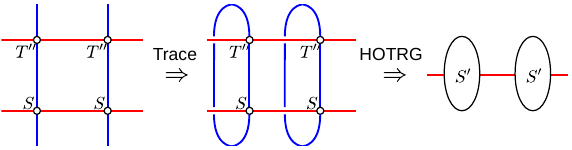
Figure 6 . The second step of the algorithm. Blue (red) line denotes the temporal (spatial)